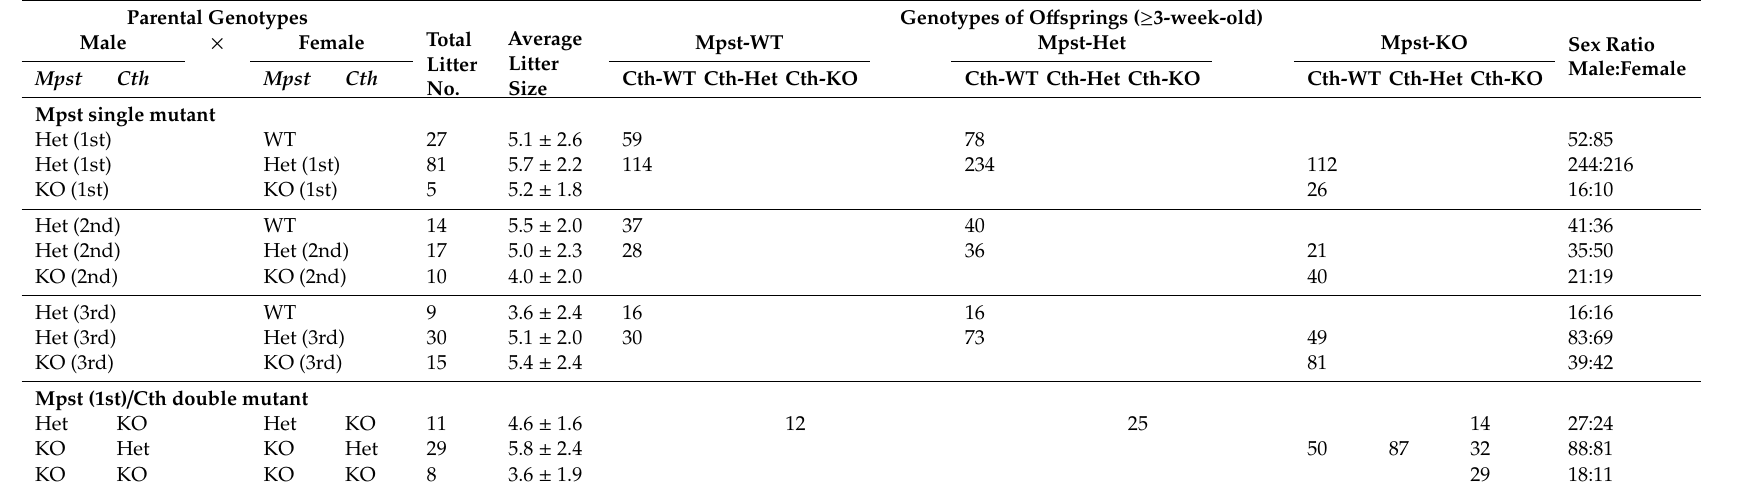
Table 1. Inheritance of the Mpst and Cth mutant alleles in